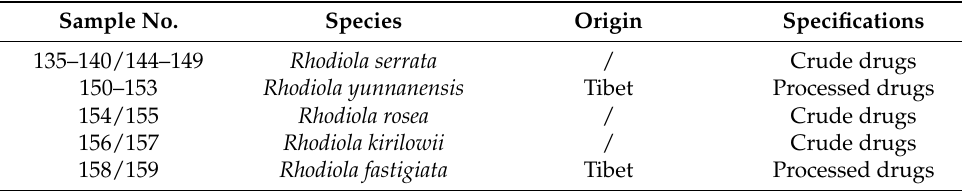
Table 2. Cont. Sample